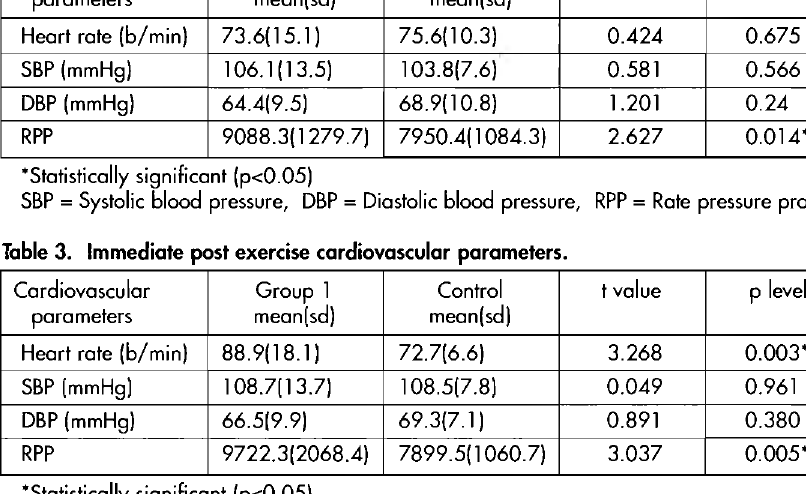
Table 2. Resting cardiovascular parameters of the subjects.